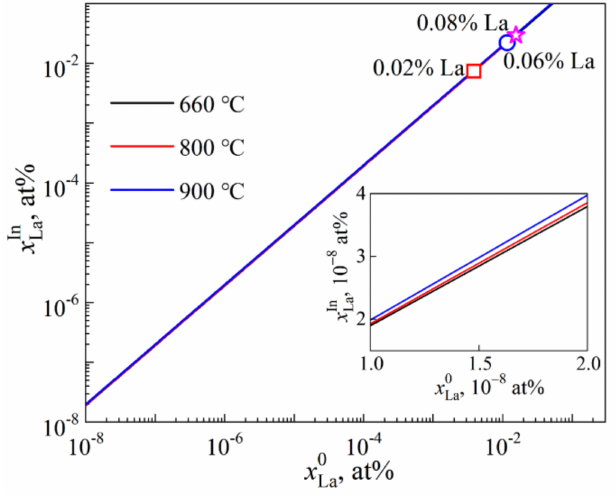
Figure 7. x In as a function of x 0 . Symbols present the points corresponding to the La addition level La La to